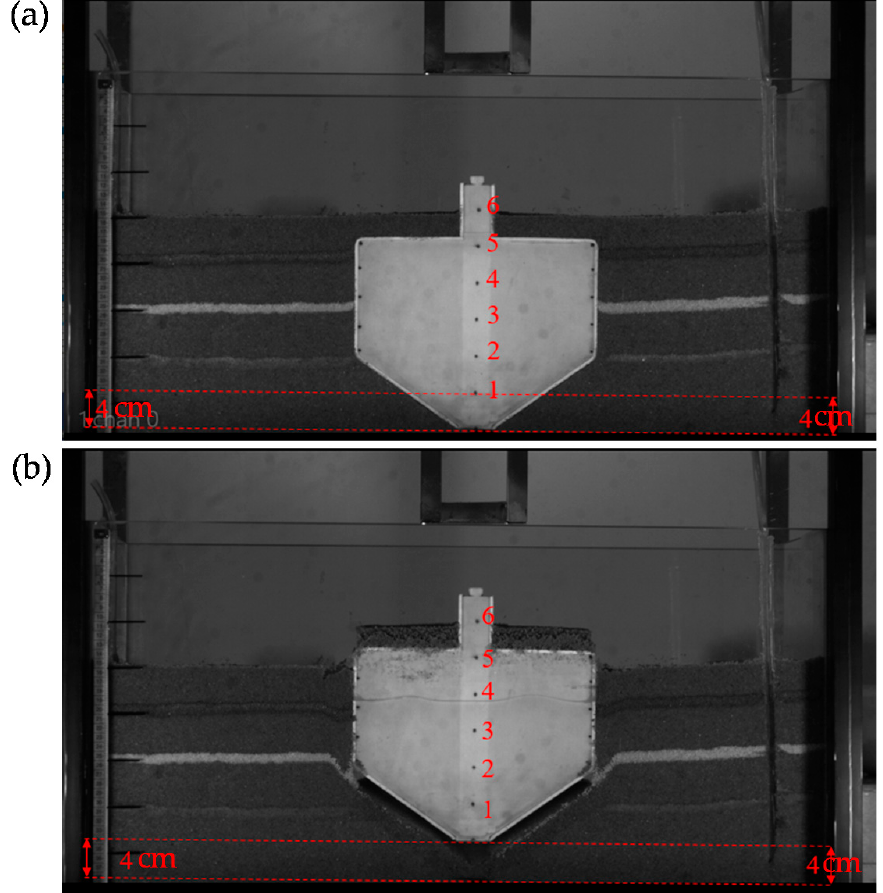
Figure 3. The upward movement of model granary: ( a ) before upward movement; ( b ) 4 cm upward movement. The displacement–time curves of the target point in the horizontal and vertical directions are measured by the non-contact video measurement system, as shown in Figure 4. In the horizontal direction, the displacement of the target point is between 0 mm and 2 mm as shown in Figure 4a. When the water supply pressure is stopped, the vertical displacement of each target point fluctuates around 4.05 cm, as shown in Figure